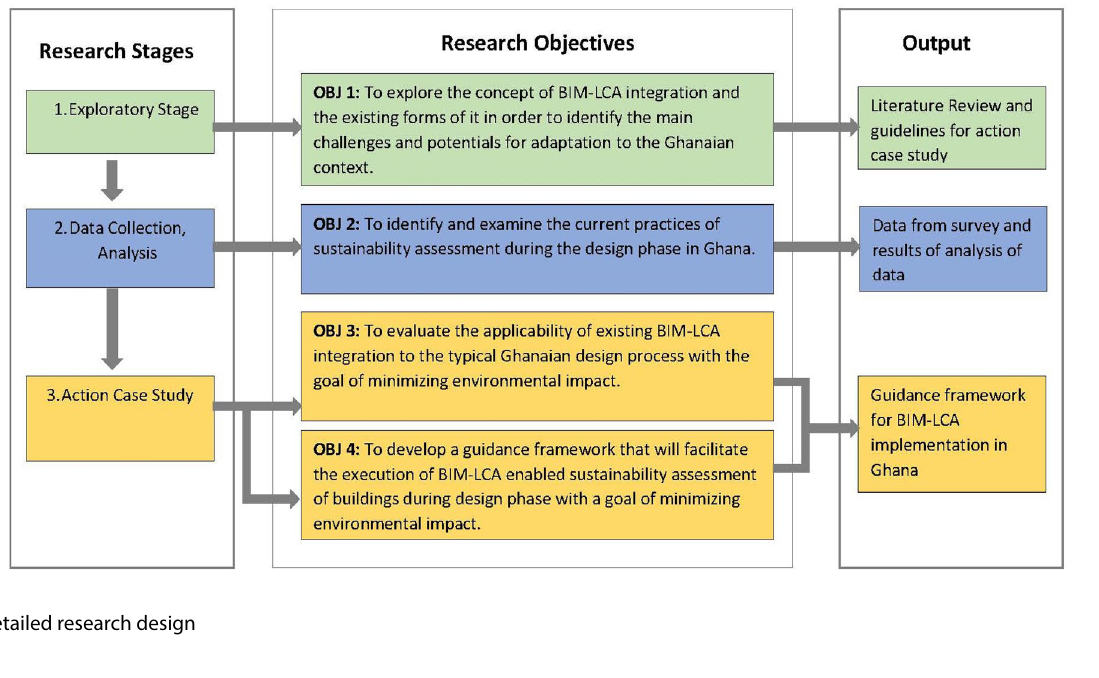
Fig. 2 Detailed research design